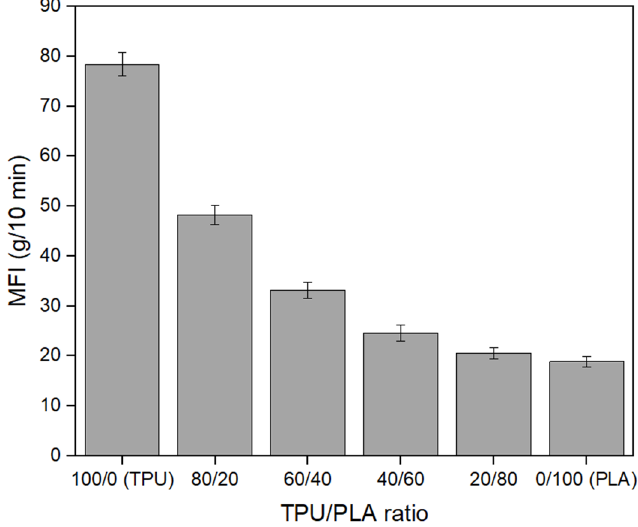
Figure 6. MFI test results of TPU, TPU/PLA blends, and PLA.